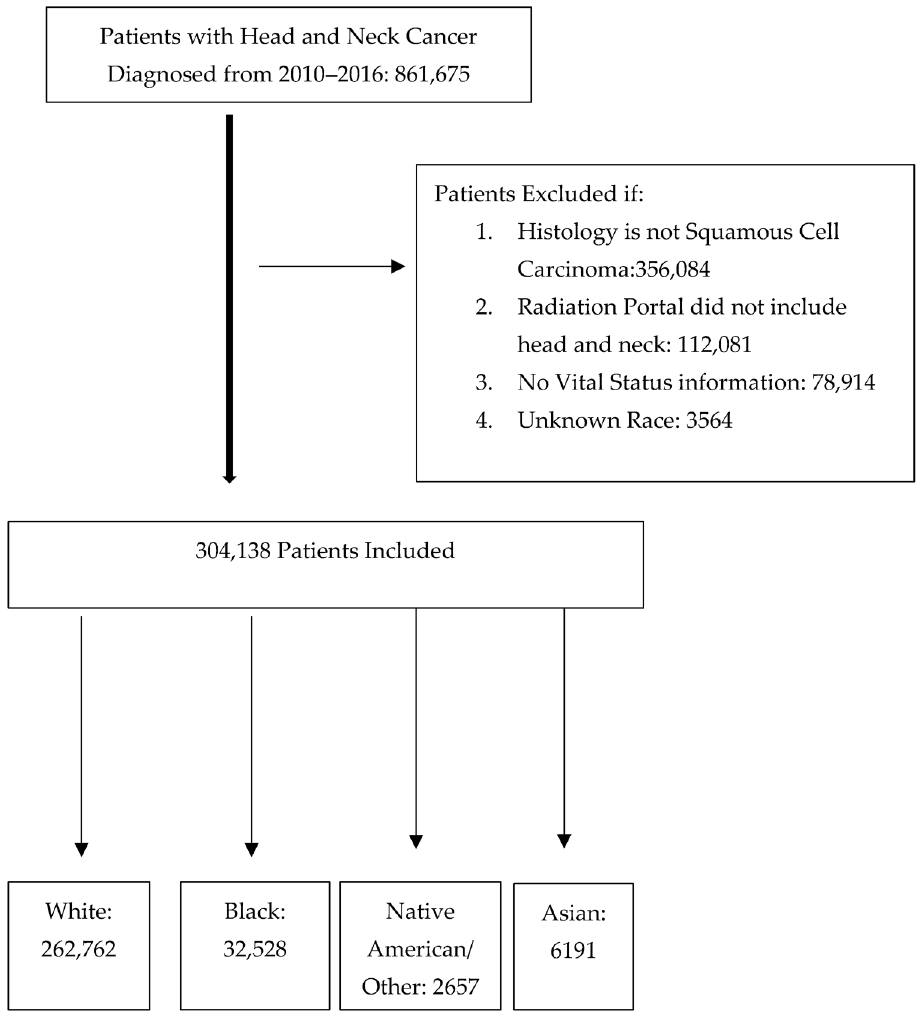
Figure 1. Selection Criteria.